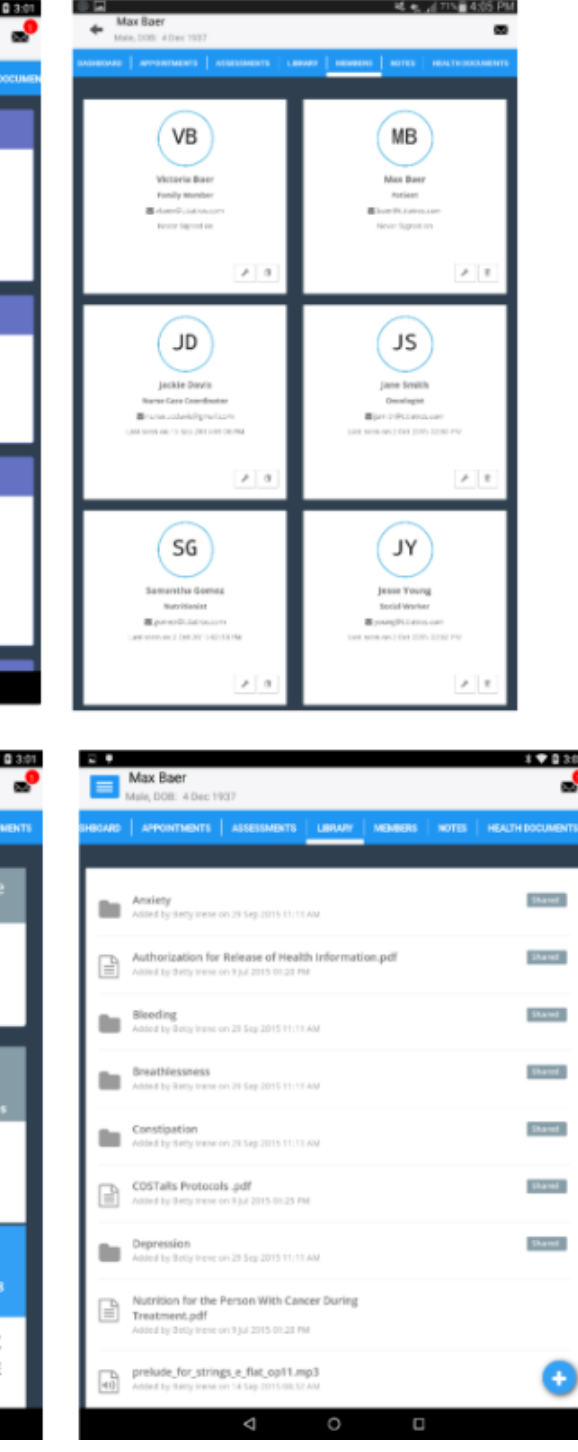
Tab Pro 8.4 SM-T325 loaded with Android 4.4 Kitkat